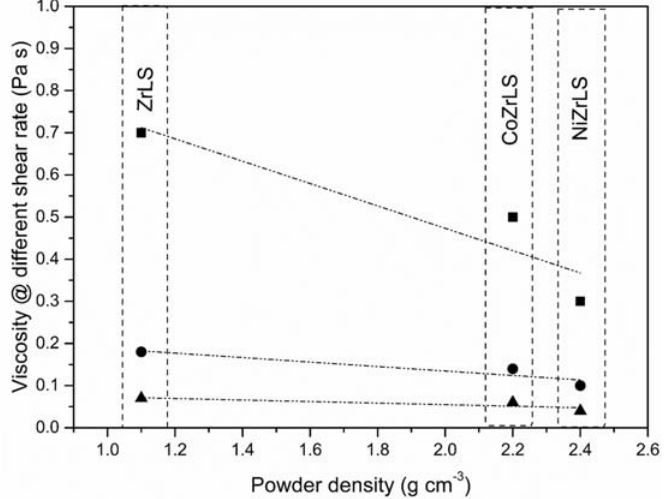
Figure 3. Viscosity at three selected shear rates as the function of the powder